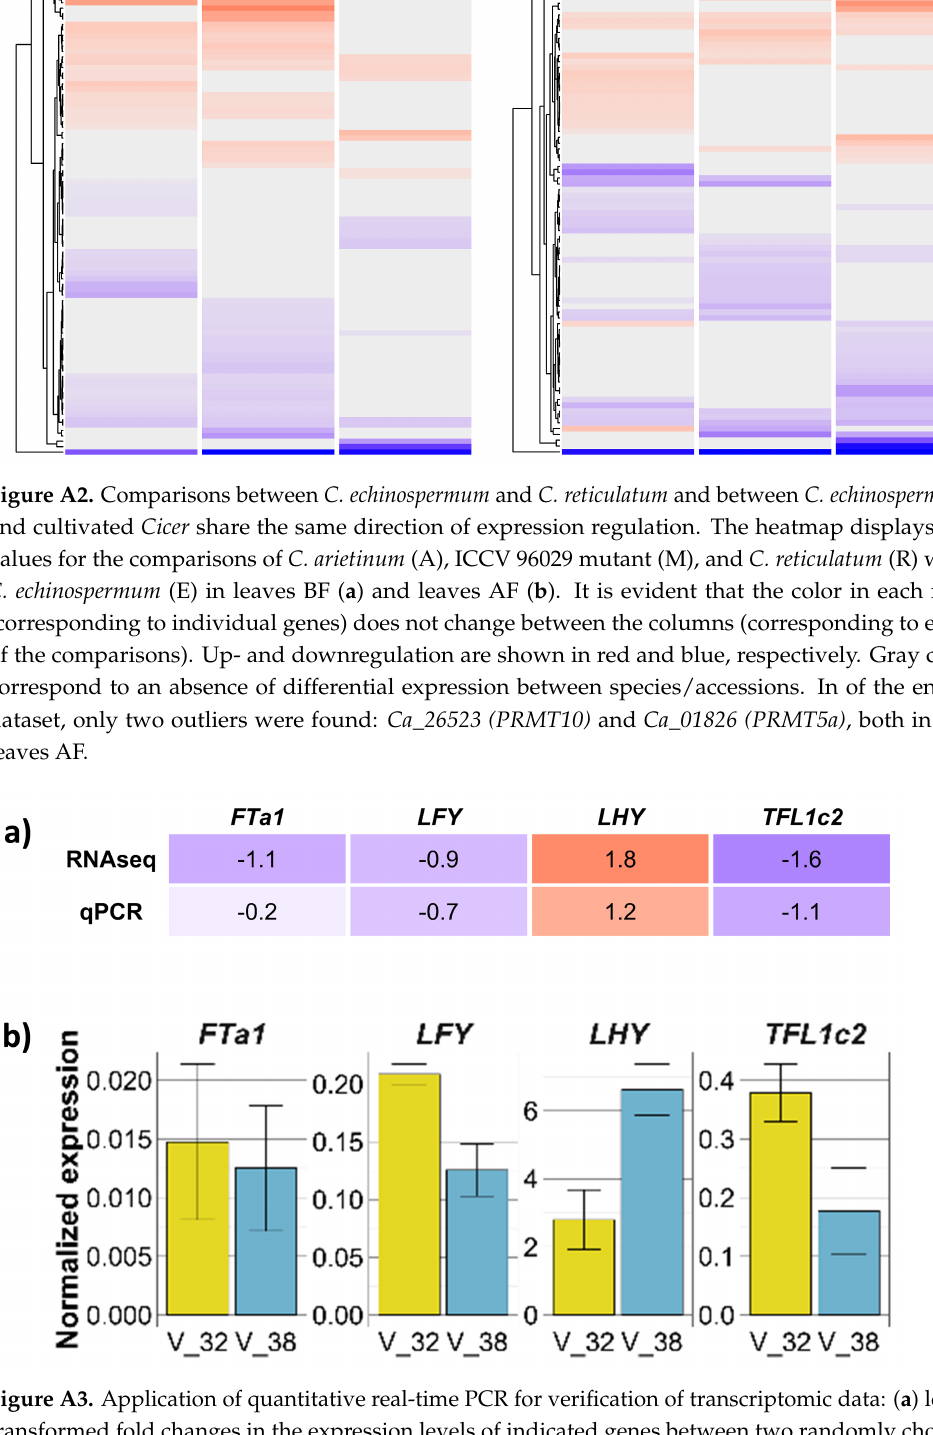
Figure A3. Application of quantitative real-time PCR for verification of transcriptomic data: ( a ) log2- transformed fold changes in the expression levels of indicated genes between two randomly chosen samples resulting from RNAseq and qPCR experiments and ( b ) the results of